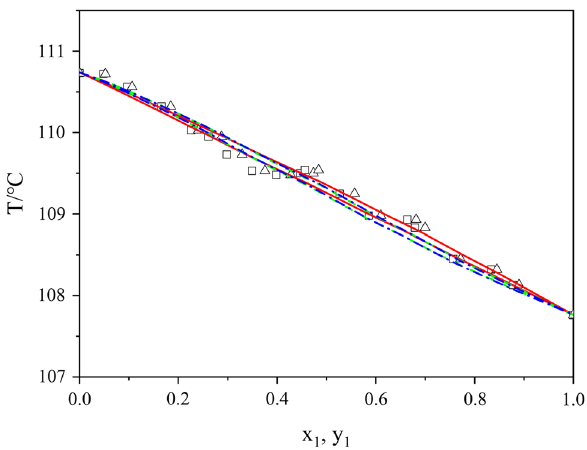
Fig. 2 Gas–liquid equilibrium diagram for the 1-dodecene (1) + n -dodecane (2) at 3.36 kPa. Square, triangle, ( x 1 , y 1 ) measure- ment data; red line, ( x 1 , y 1 ) Wilson model fitting results; green dashed line, ( x 1 , y 1 ) NRTL model fitting results; blue dashed line, ( x 1 , y 1 ) UNIQUAC model fitting